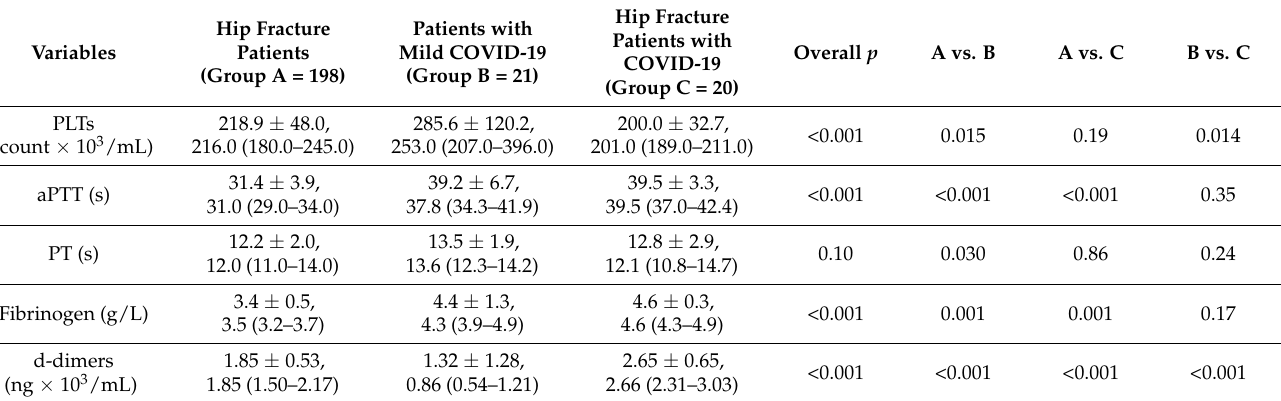
Table 2. Conventional coagulation assays of the study